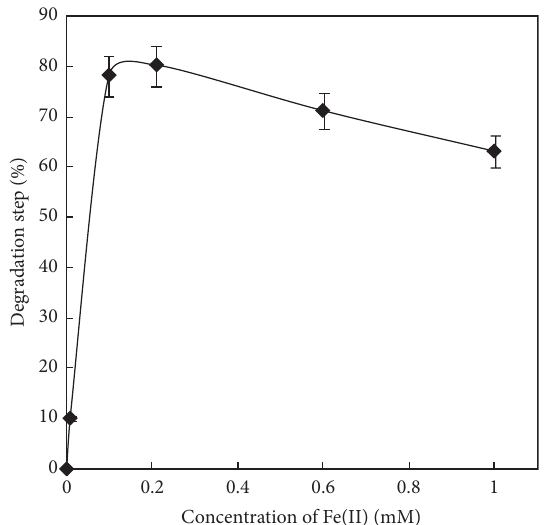
Figure 3: Effect of Fe 2+ concentration on the step of degradation, 𝑆 𝐷 , of p -HBA.